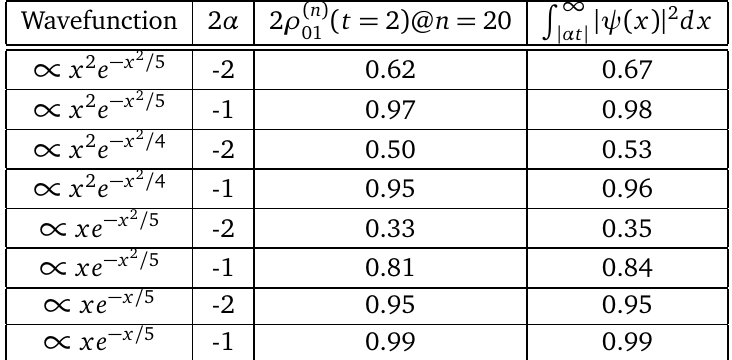
Table 1: Testing the limit numerically for a variety of initial wave functions and parameters α . We chose a discretization of ∆ x = 0.01 and a cut-off of x ≤